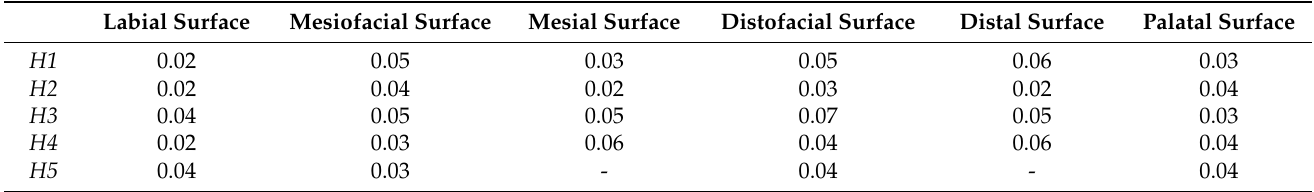
Table 1. Median of difference between e1 (measured by OCT) and e2 (measured by microscopy) for maxillary central incisors